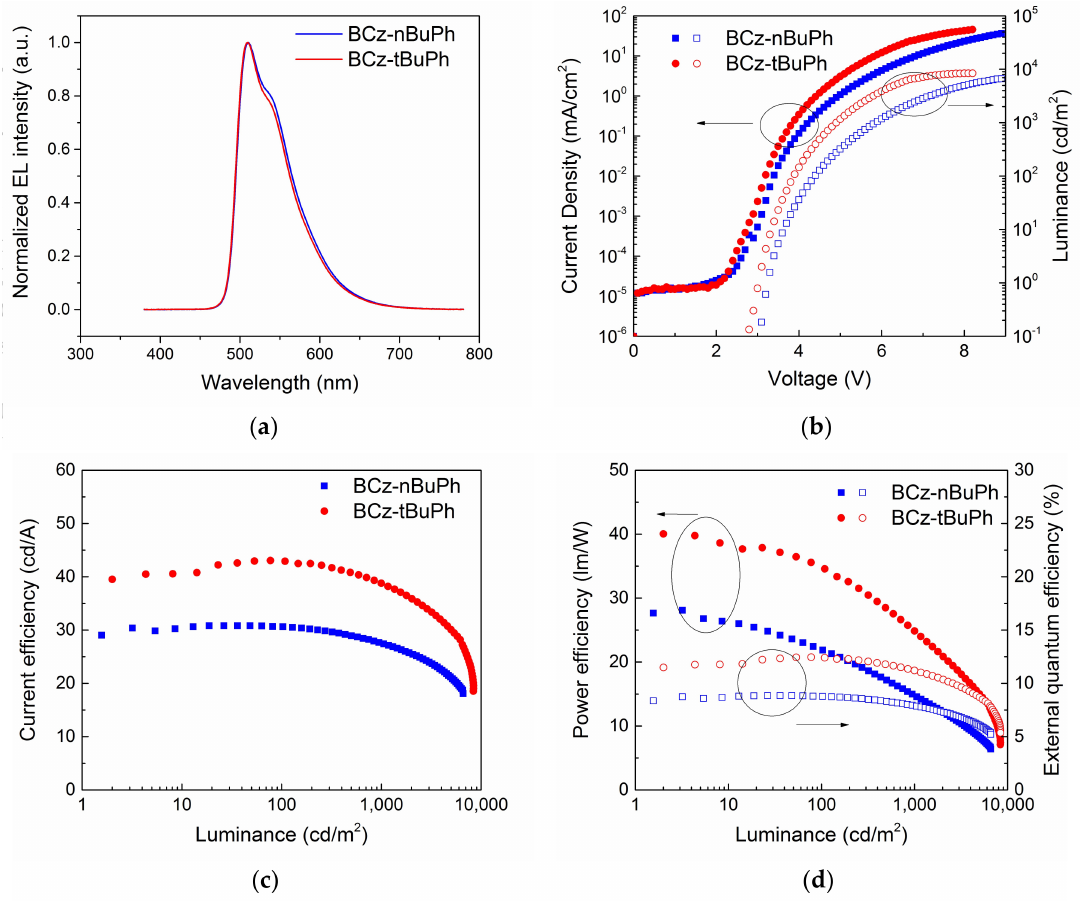
Figure 4. Electroluminescence (EL) spectra ( a ), current density-voltage-luminance ( b ), current efficiency-luminance ( c ), and power efficiency-luminance characteristics ( d ) of solution-processed green PHOLEDs using BCz-nBuPh and BCz-tBuPh ,